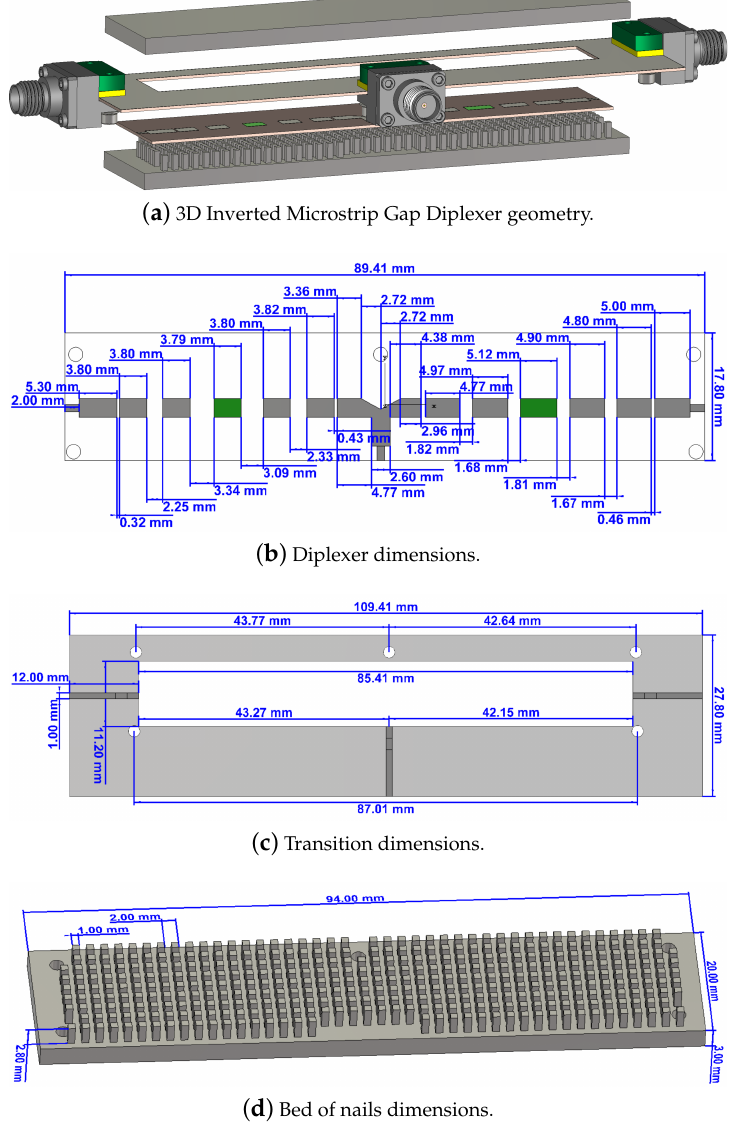
Figure 10. Inverted Microstrip Gap Diplexer geometry and